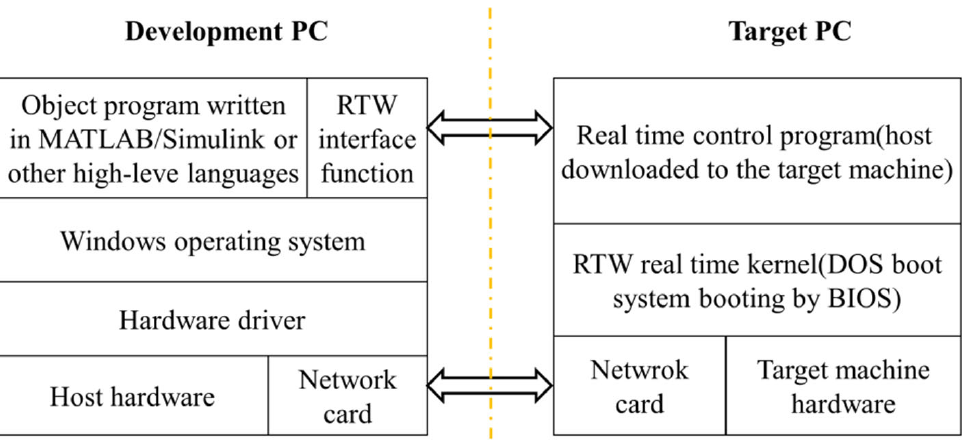
Figure 4. System communication framework.